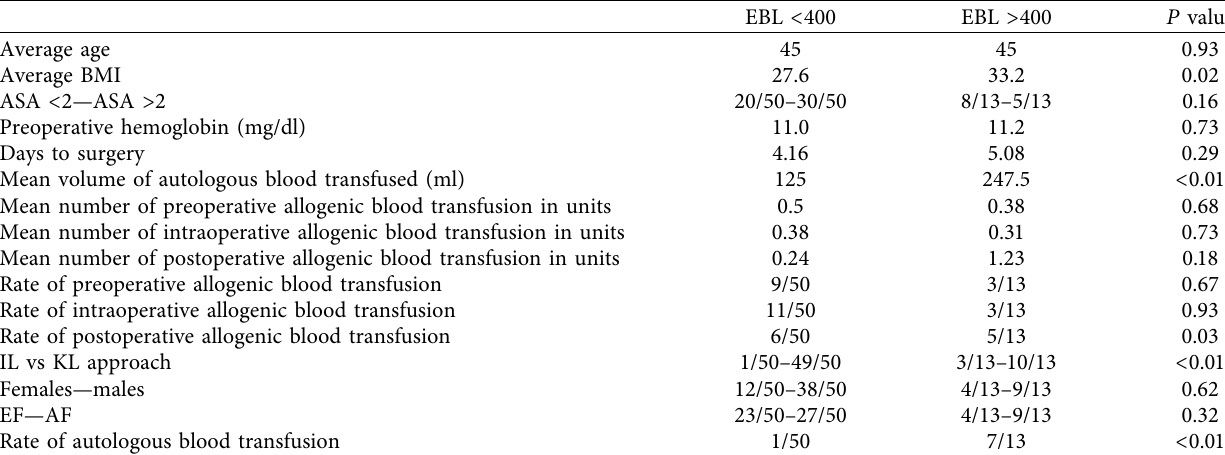
Table 5: Patients with EBL > 400ml were more likely to have an elevated BMI and received higher volumes of blood when autologous transfusion was provided. The rate of requiring a postoperative allogenic transfusion was higher when EBL > 400ml. The rate of having EBL > 400ml was higher in fractures requiring treatment with an anterior surgical approach. The rate of receiving an autologous transfusion was higher when EBL > 400ml. IL � Ilioinguinal, KL � Kocher-Langenbeck, ASA � American Society of Anesthesiology Score, BMI � body mass index, EBL � estimated blood loss, EF–elementary fracture pattern, AF � associated fracture pattern.